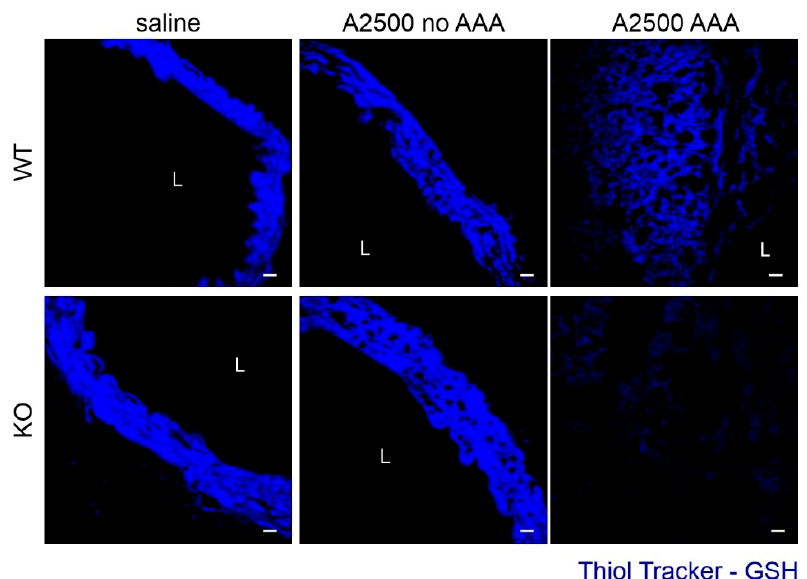
Figure 4. Enhanced oxidative stress is present only in the formed aneurysms. The mice were infused with either saline or angiotensin II at the dose 2500 ng/kg/min using the osmotic pumps for 14 days. Redox status of the aortas was assessed using Thiol Tracker, which detects reduced thiols. Representative pictures, scale bar 50 µm.